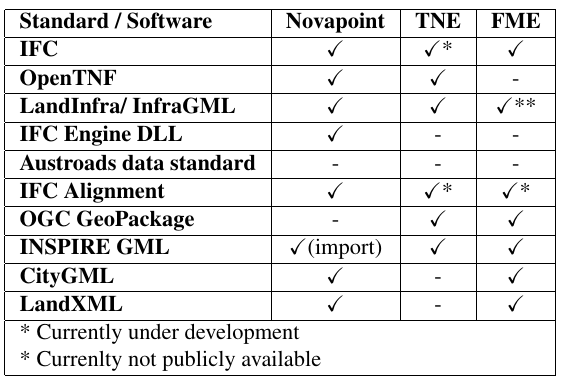
Table 1. Comparison of the software Trimble Novapoint, Triona TNE and Safe Software FME with applicable data standards for road asset information